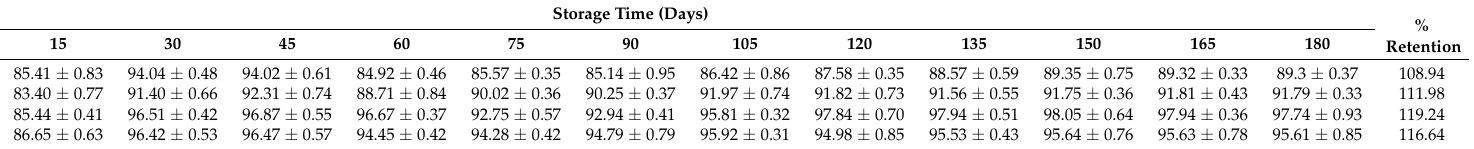
Table 3. Stability profile of hydroxychavicol (HC) under different storage temperatures and light for 180 days 1 .